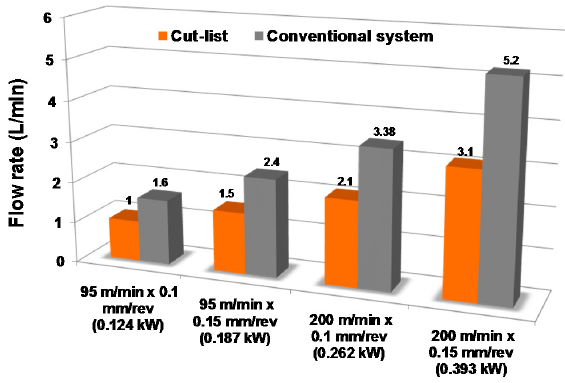
Figure 5. Flow rate versus cutting condition and generated heat for the two supply systems.